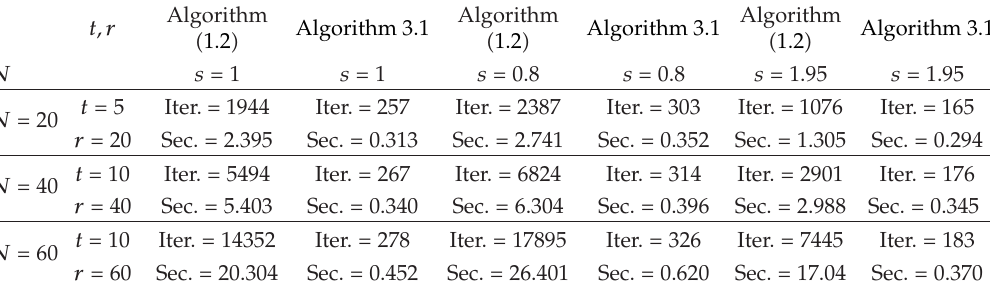
Table 2: The numerical results of Example 4.2. Algorithm 3.1 Algorithm 3.1